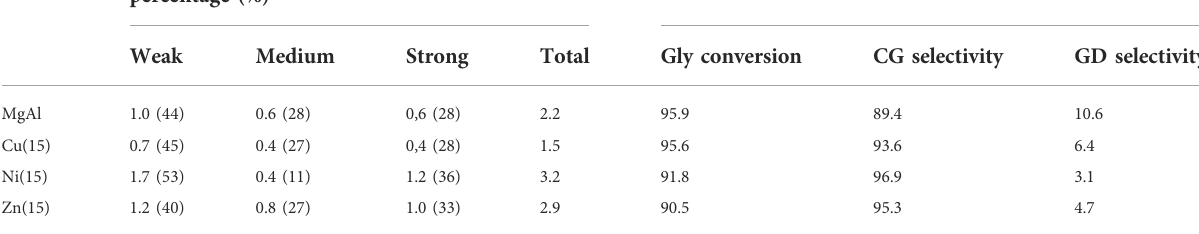
TABLE 3 Basic properties and catalytic activity of the mixed oxides.